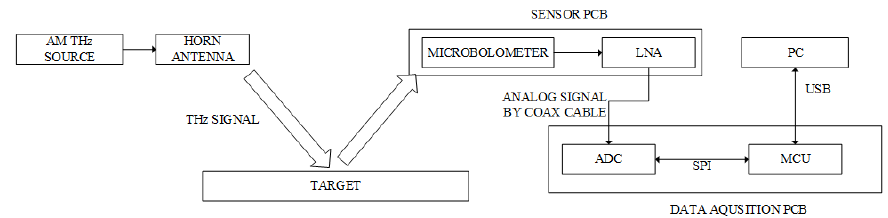
Figure 3. Schematic diagram of the experimental setup.